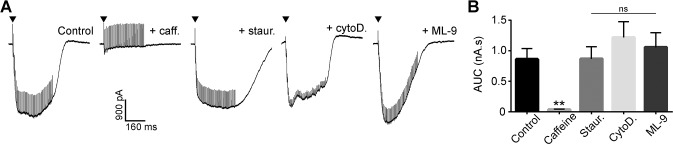
Disruption of vesicle trafficking.A) Representative whole-cell recording of neuronal EPSCs during tetanic stimulation (100 Hz, 50 pulses). Recordings are shown from the same cell before and after addition of 50 mM caffeine to bath solution. Independent recordings are next shown from cells pre-incubated with 5 μM staurosporine, 10 μM cytochalasin D, and 25 μM ML-9, respectively. Arrows indicate the initiation of tetanic stimulation. B) Area under curve (AUC) values measuring the inward current generated by tetanic stimulation. Areas were measured over a 1 s period, starting from 0.05 s prior to the onset of tetanus. Data are mean + s.e.m. from 3–8 cells, respectively, from 1–4 animals, respectively. Statistical significance was tested using one-way ANOVA with Dunnett’s Multiple Comparison test to compare each group to control. ** indicates a P value of 0.0037, ns indicates a P value of > 0.05. Slices were incubated with 2 μM DPCPX, 10 μM CGP52432, 100 μM MPPG, and 5 μM rimonabant to inhibit presynaptic inhibitory receptors.